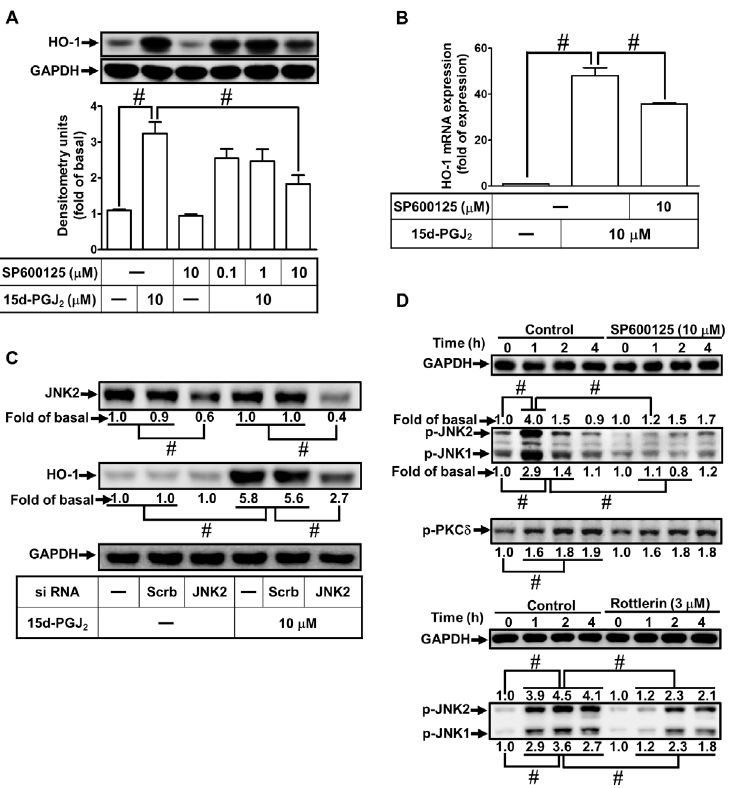
Figure 4. Involvement of JNK1/2 in HO-1 expression stimulated by 15d-PGJ 2 in bEnd.3 cells. ( A ) The cells were pretreated with the indicated doses of SP600125 for 1 h before incubation with 15d-PGJ 2 (10 µ M) for 6 h. To determine the HO-1 protein expression, the cell lysates were examined by Western blot with GAPDH as an internal control. ( B ) The cells were pretreated with SP600125 (10 μM) for 1 h and then treated with 15d-PGJ 2 (10 μM) for 4 h. The mRNA levels of HO-1 were quantified by real-time PCR. ( C ) The cells were transfected with JNK2 siRNA and then challenged by 15d-PGJ 2 (10 μM) for 6 h. The protein levels of JNK2 and HO-1 were examined by Western blot with GAPDH as an internal control. ( D ) The cells pretreated with SP600125 (10 μM) or Rottlerin (3 μM) for 1 h were stimulated by 15d-PGJ 2 (10 μM) for 1, 2, and 4 h. The phosphorylation of JNK1/2 or PKCδ was